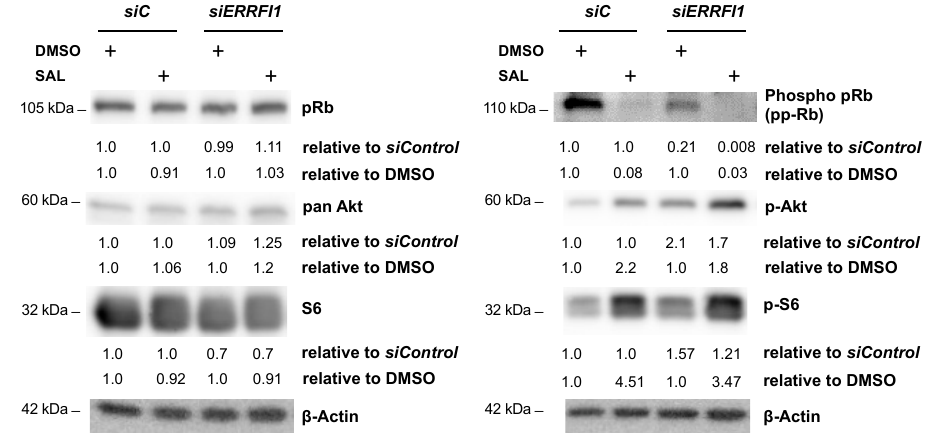
Figure 6. siRNA mediated knockdown of ERRFI1 decreases phospho-p-Rb (pp-Rb) and enhances p- AKT and p-S6 levels. siERRFI1 knockdown LNCaP cells treated for 72 h were analyzed for changes in pRb, AKT and S6 levels using Western blotting. siControl ( siC ) served as transfection control. Upper numbers indicate the fold-change of protein level relative to the particular treatment in transfected control cells. Lower numbers indicate a fold-change of protein levels relative to solvent control DMSO.